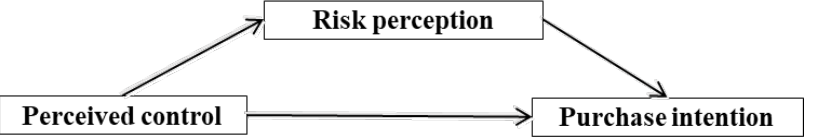
Figure 2. Hypothesized relationship among perceived control, risk perception, and purchase inten-